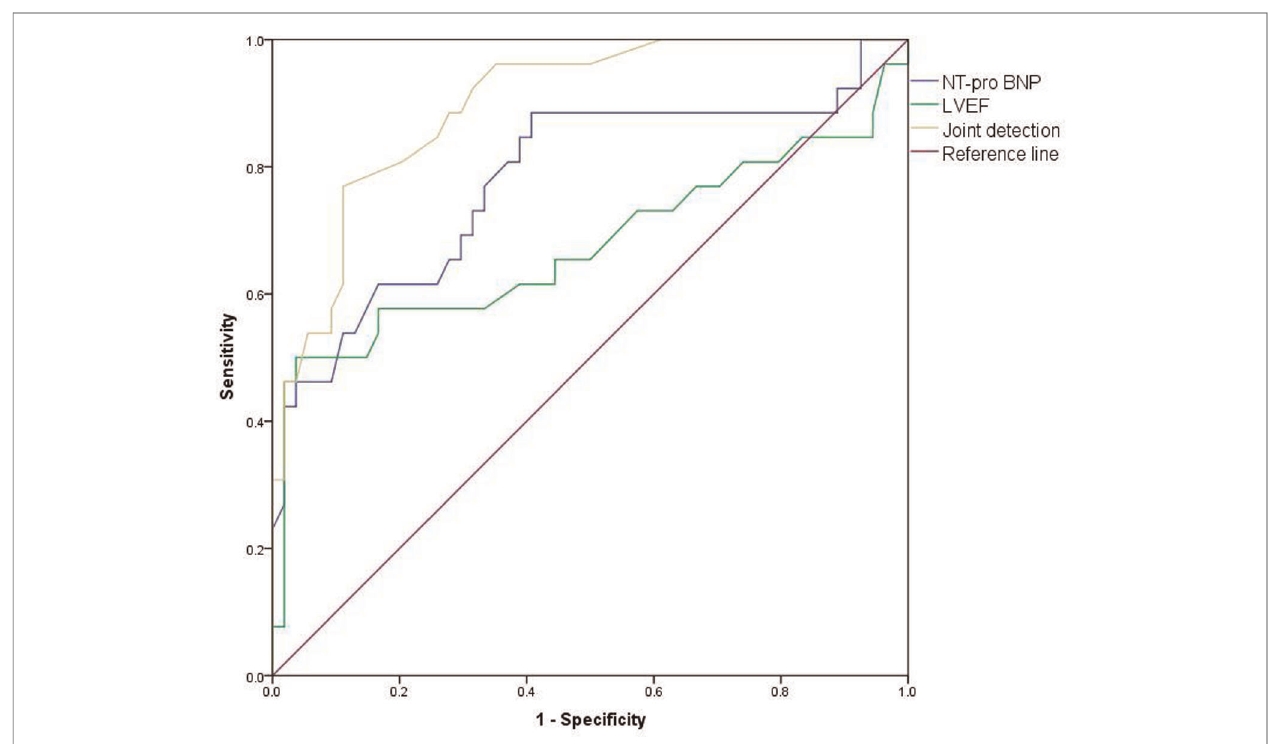
FIGURE 8 | ROC curve of predictive value of NT-proBNP and echocardiography monitoring on cardiotoxicity of